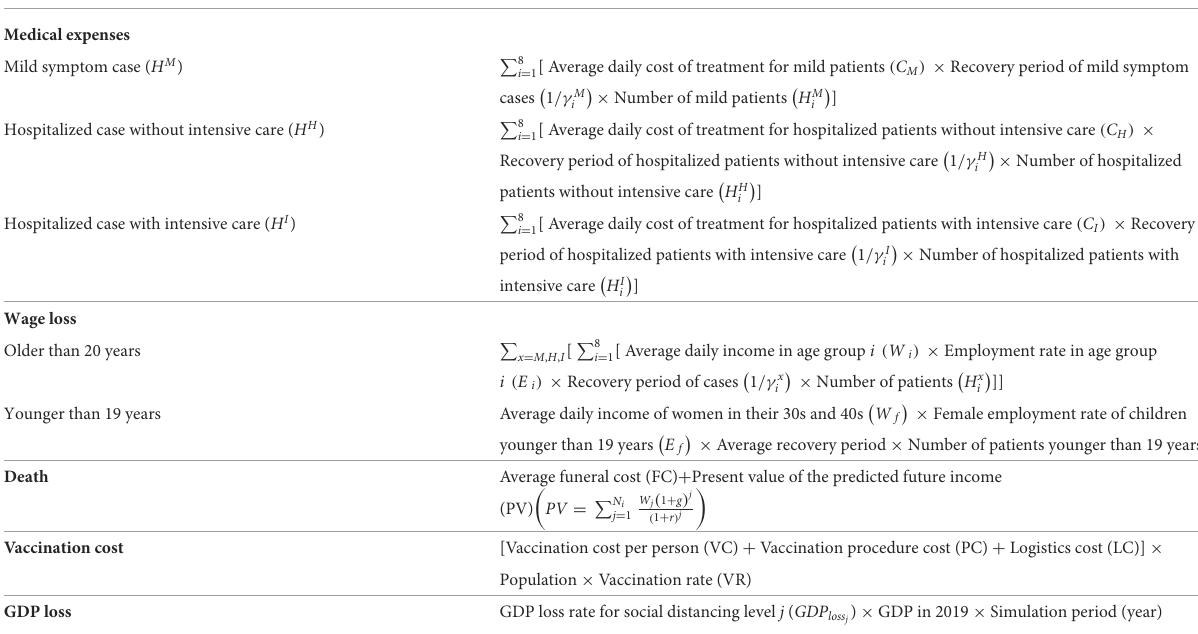
TABLE 2 Formulae for the cost estimation. Cost factor Formula